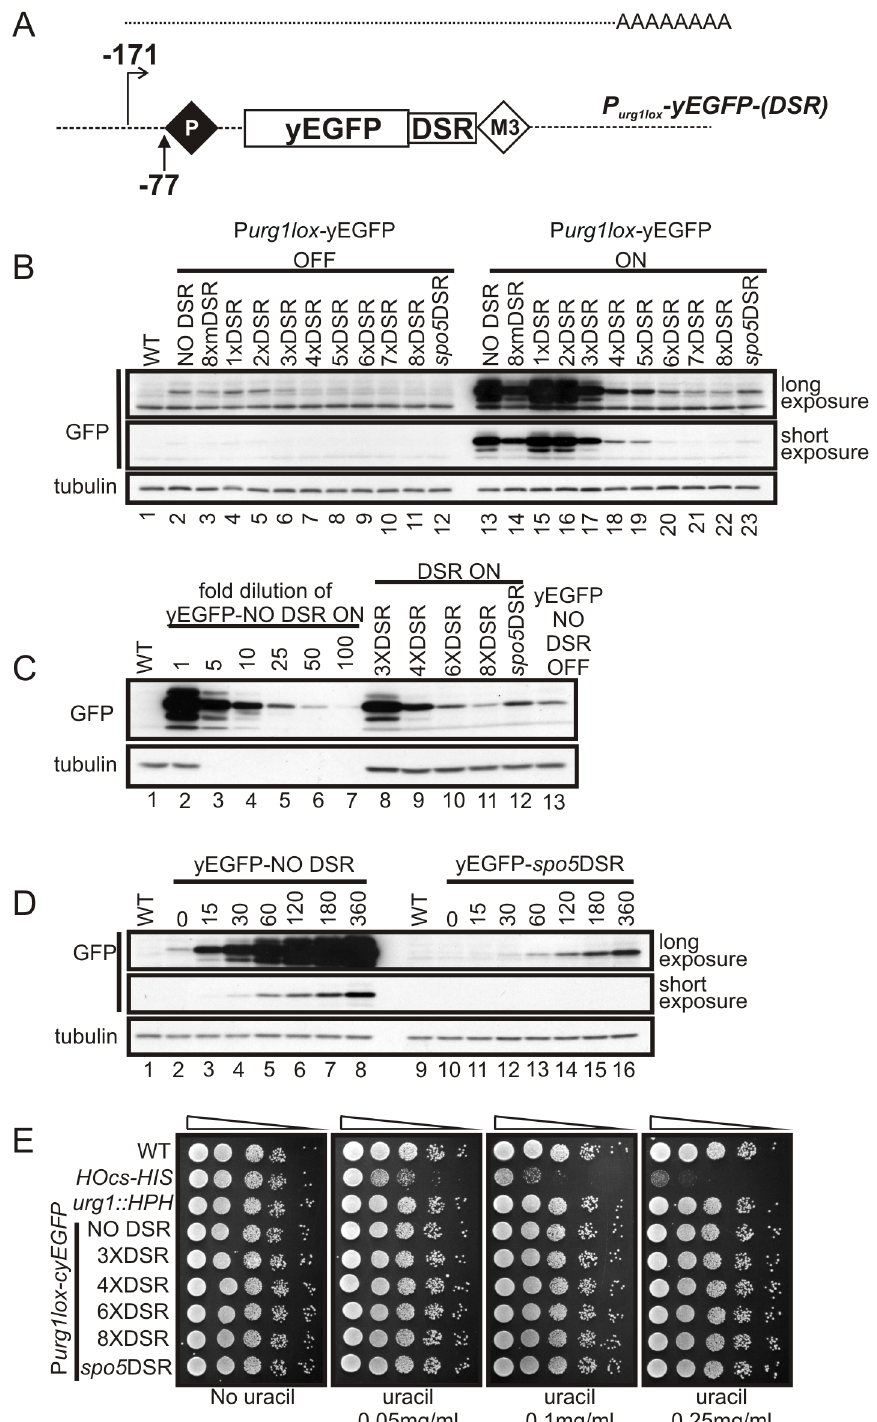
Figure 2. Determinant of Selective Removal (DSR) sequences can reduce protein levels expressed from P urg1lox . ( A ). Schematic of the P urg1lox locus following RCME to introduce yEGFP under the control of the urg1 promoter. The resulting transcript encodes the ORF followed immediately after the stop codon by one of a variety of DSR sequences. These act to target the transcript to the nuclear exosome. ( B ). The strains created with the yEGFP ORF with and without DSR sequences present in the 3’ UTR: AW640 (NO DSR), AW702 (8XmDSR), AW726 (1XDSR), AW728 (2XDSR), AW730 (3XDSR), AW732 (4XDSR), AW694 (5XDSR), AW696 (6XDSR), AW698 (7XDSR), AW700 (8XDSR) and AW638 ( spo5 DSR) (see also Table 1). The strains were cultured in EMM + L to , 5 6 10 6 cells at 30 u C (uracil absent - P urg1lox OFF). Uracil was added at 0.25 mg/ml and cells grown for 120 minutes (P urag1lox ON). Total protein extracts from un-induced P urg1lox OFF cells (lanes 2–12) and induced P urg1lox ON cells (lanes 13–23) were separated by SDS PAGE prior to Western blotting using anti-GFP to detect yEGFP (upper panels) and anti-tubulin for a loading control (lower panel). Lane 1 = WT control urg1 + strain (AW501). ( C ) Comparison of the induced P urg1lox -yEGFP levels in B. Induced cell total protein extracts were used to estimate